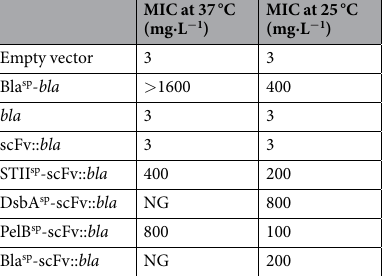
(Supplemental Fig. S4) and compared to PelB sp -scFv:: bla , scFv:: bla without a signal peptide and the empty vector (pLBAD2) as controls. The majority of clones had a similar β -lactamase activity to PelB sp -scFv:: bla . Some clones